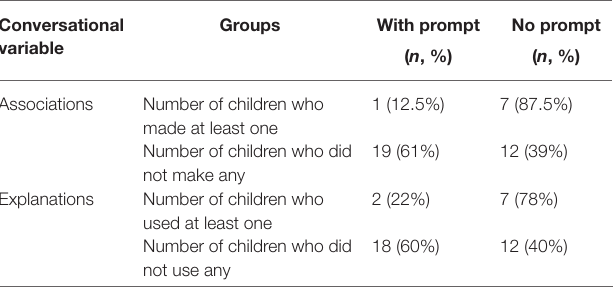
TABLE 4 | Crosstabulation of children using explanations or not and receiving experimentation activity prompt or not. Conversational variable